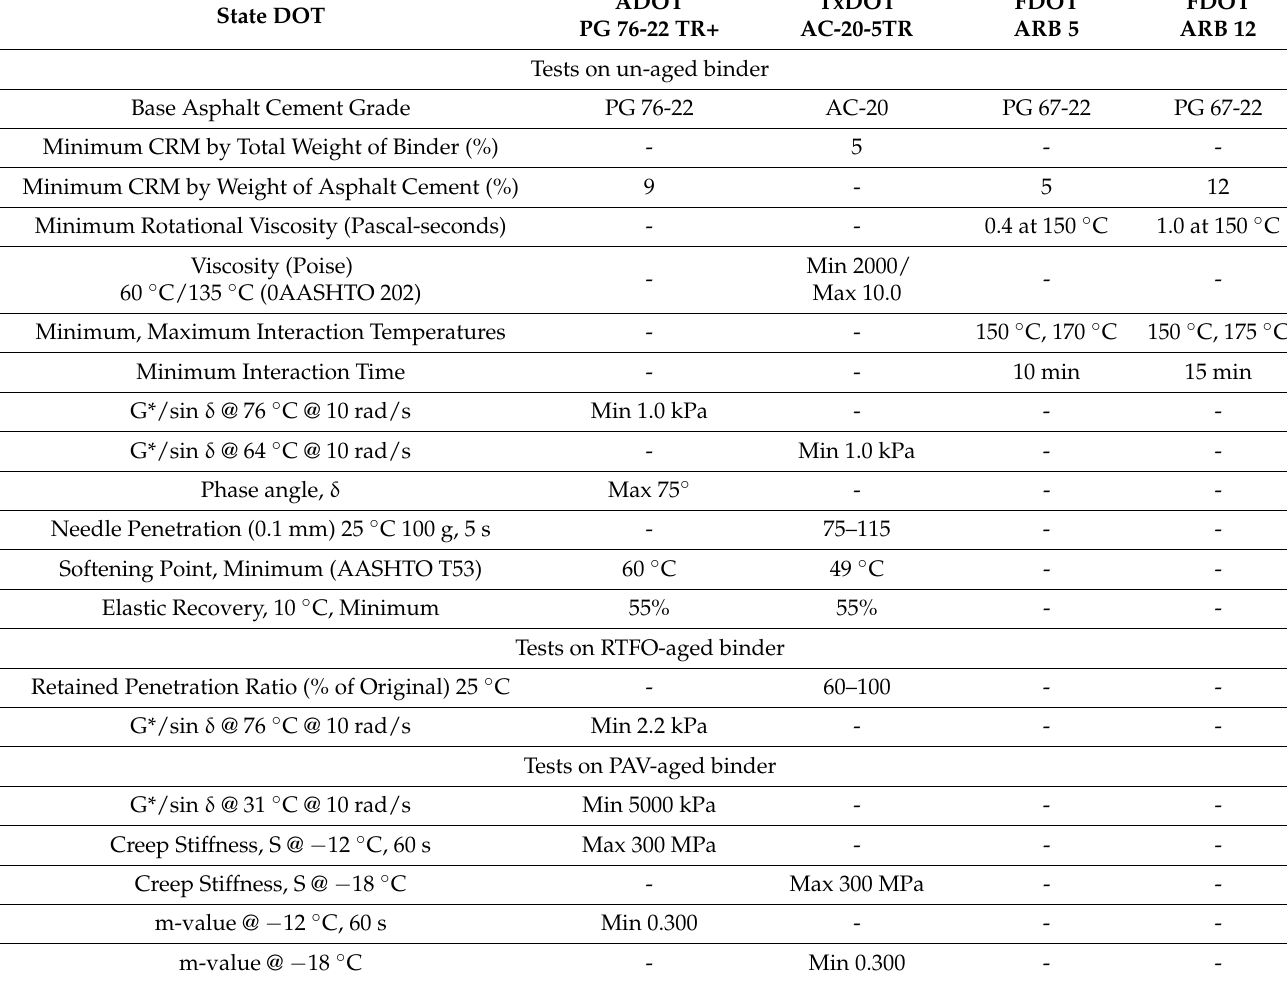
Table 6. State DOT specifications for terminal-blended CRM